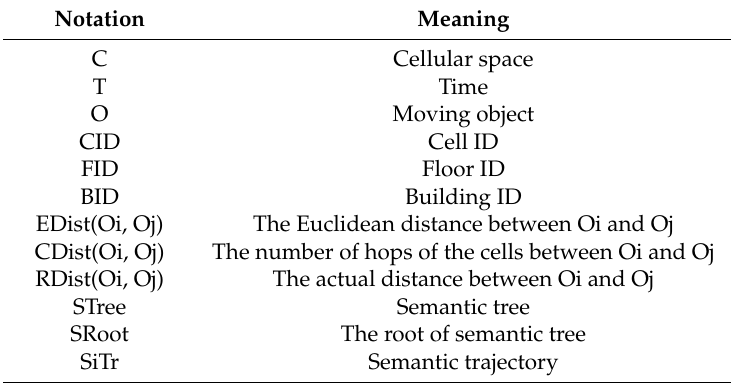
Table 1. Notations used throughout this